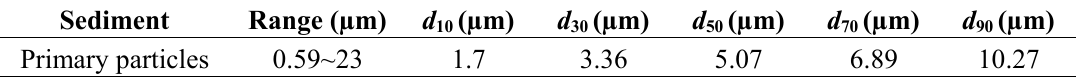
Figure 1. Particle size distribution of the kaolin. The left vertical axis (corresponding to blue bars) and the right one (corresponding to the black curve) denote the individual and cumulative percentile of different-sized particles over the total, respectively, whereas the longitudinal axis represents different size values (the unit is micron). Table 2. Particle-size distribution statistics for the